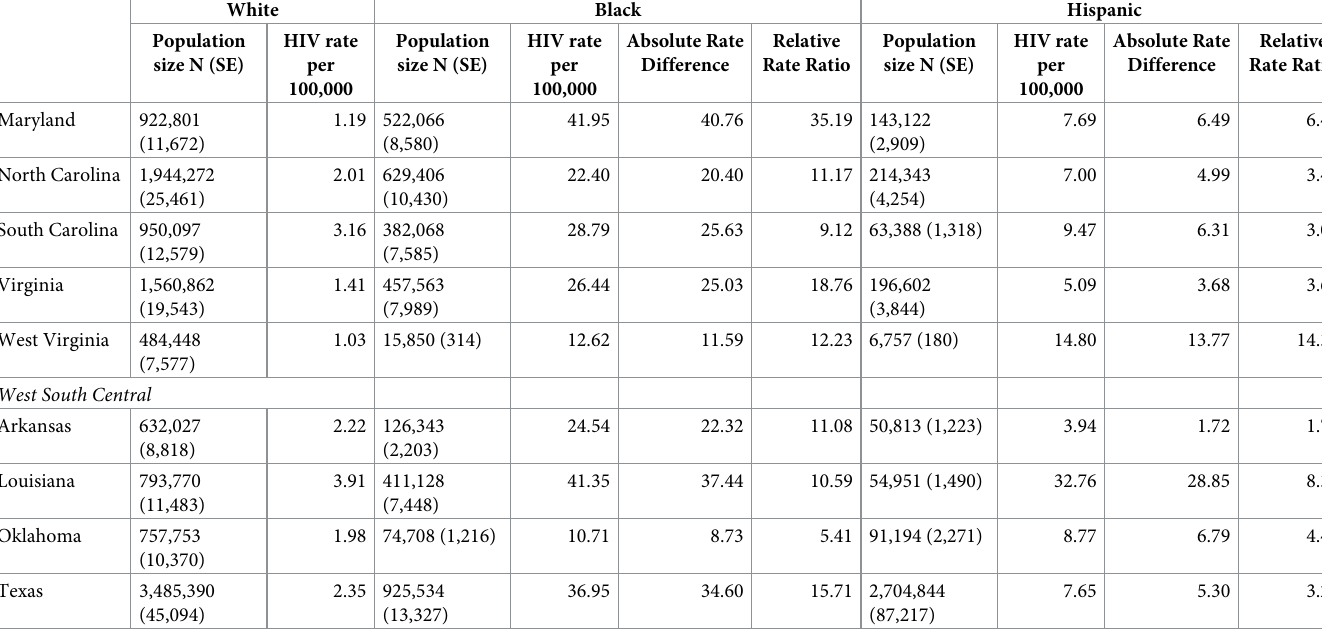
2.47). On the absolute disparity measure, the Black-to-White disparities were highest in the South which differed from findings from the relative measure (RD, Midwest: 24.78, Northeast: 29.33, South, 33.92, West: 30.21). Consistent with findings from the relative measure, the His- panic-to-White disparities remained higher in the Northeast on the absolute measure (RD, Midwest: 3.35, Northeast: 10.74, South, 6.76, West: 2.67) The hex maps (Fig 3) illustrate these findings visually. The high Black-to-White and Hispanic-to-White rate ratios in the Northeast are likely driven by the Mid-Atlantic states, as three of the six New England states had insuffi- cient data to calculate rate ratios. Comparison of rates and disparity measures with different denominators Qualitatively, conclusions were similar when comparing HIV diagnosis rates and disparity measures between estimates using the Census population (irrespective of reported past-year sexual activity) versus our adjusted estimates among HAAs. HIV diagnosis rates and RDs had higher magnitudes when using estimated HAA population size as denominators, as HAAs are a subset of the US population. However, states’ relative rankings on HIV diagnosis rates, RDs, and RRs were consistent when using HAAs or total population as